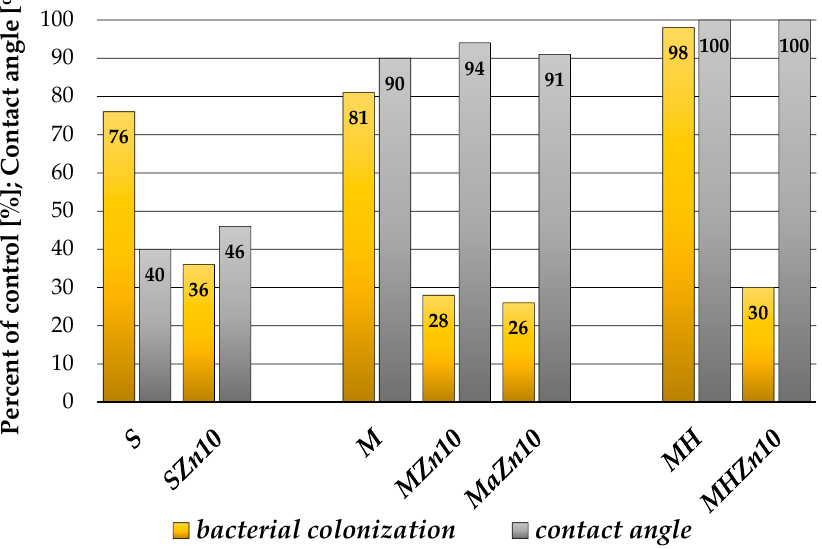
Figure 10. Comparison of mean wettability of the coatings and their colonization by E. coli .